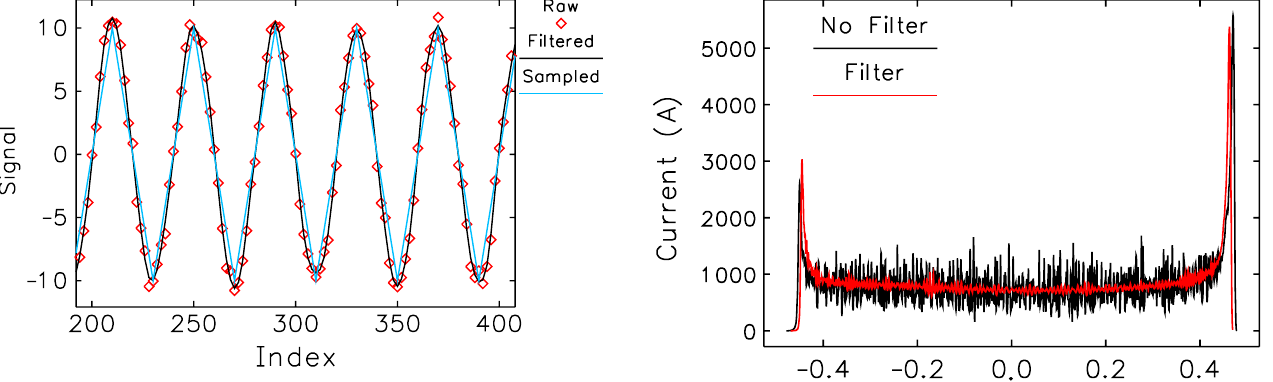
4. (Color) Illustration of why finer sampling combined with filtering is superior to coarse sampling. The original signal is a sinusoid to which 10% random noise is added. A filter is applied (cid:6) 1 = 5 and c (cid:6) 1 = 4 , giving the ‘‘Filtered’’ signal. This with c 1 2 is compared to a pure sinusoid that is simply sampled 1 = 5 as